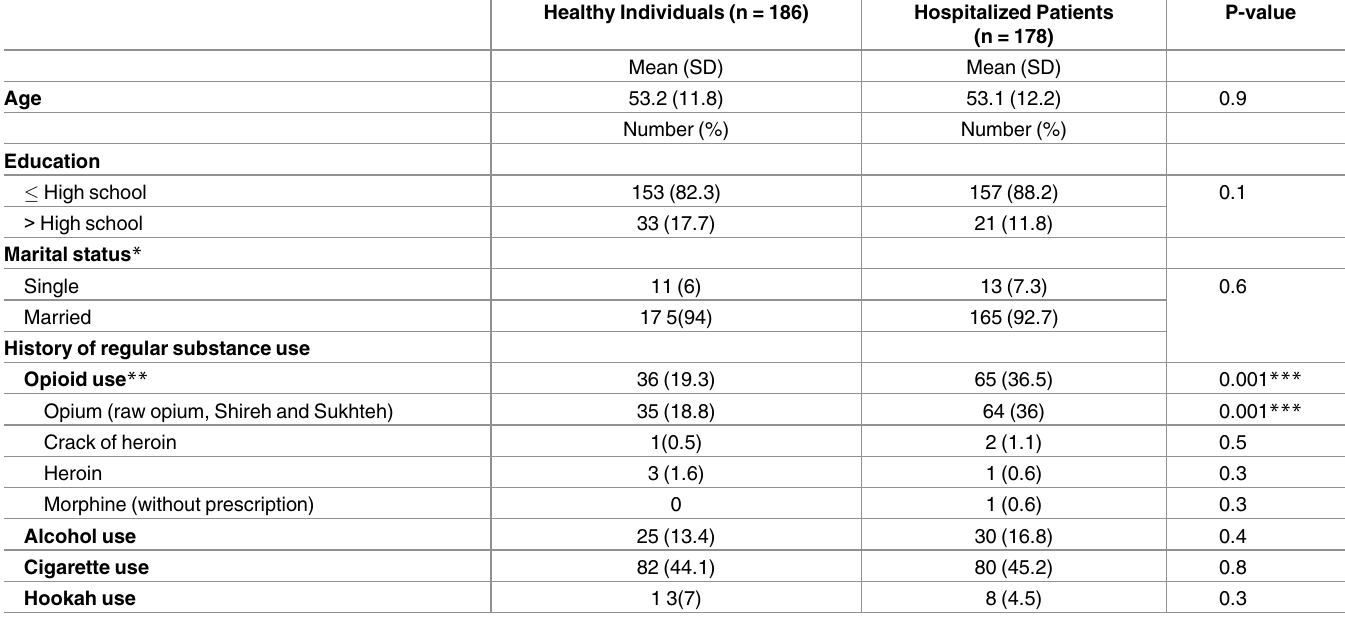
Table 1. Comparison of healthy individuals and hospitalized patients according to demographic variables and self-reported regular substance